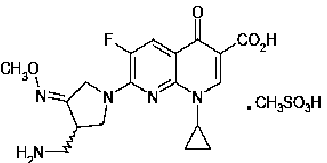
Figure 1. Chemical structure of gemifloxacin